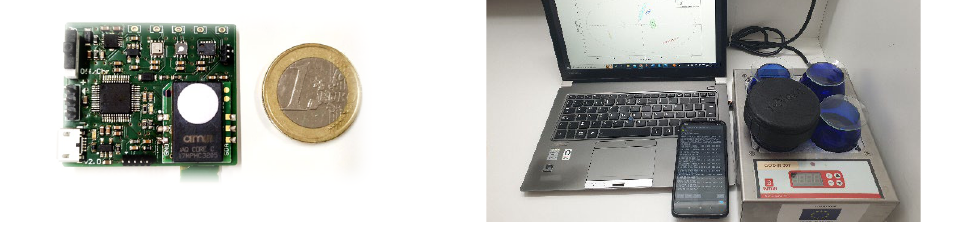
Figure 2. Electronic nose device ( left ) and the components involved in E-nose measurements ( right